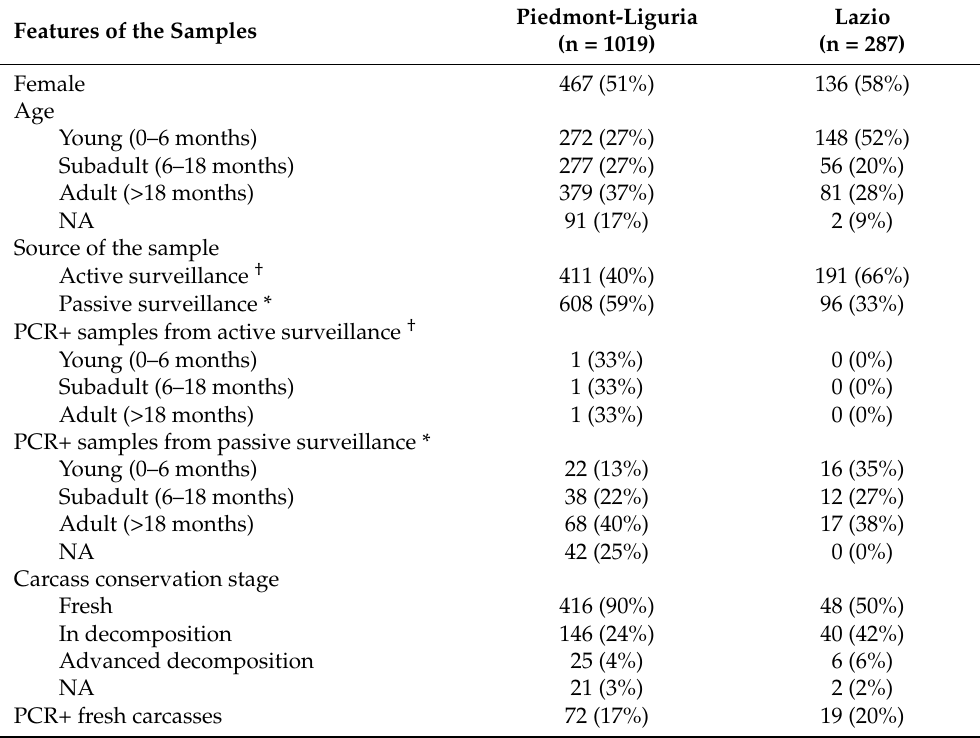
Table 1. Characteristics of the wild boar samples collected in the two main Italian infected areas